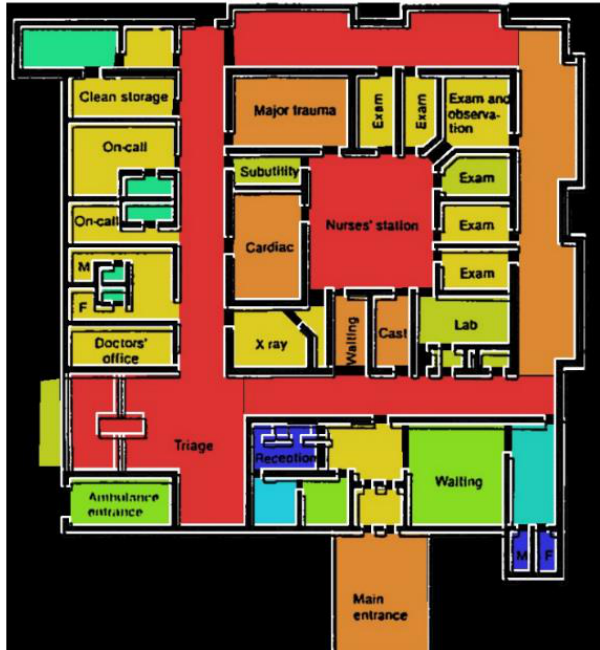
Fig. 6. Convex map Analysis of Core Type Emergency Department